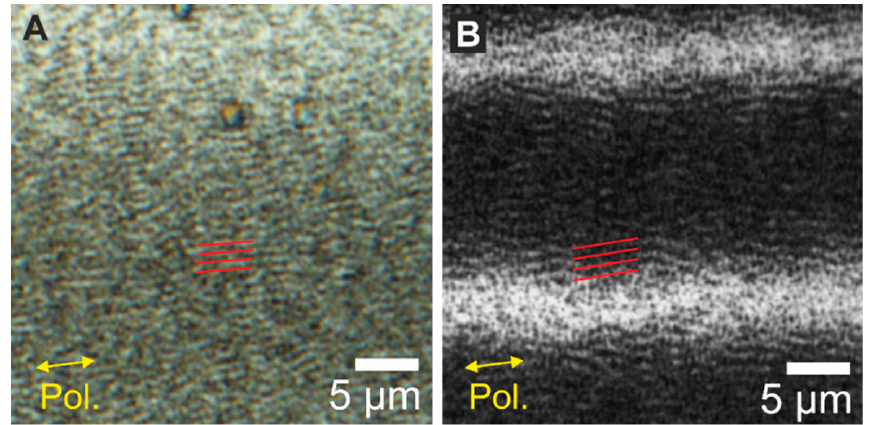
Figure 4. Morphological characterization via top-view optical microscopy (OM) of the samples irradiated with ( A ) Ti:Sa laser system ( λ = 790 nm), using the same parameters of Figure 3B, featuring the structures parallel to the laser polarization, highlighted with a set of four parallel red lines, and ( B ) Yb-doped fiber laser system ( λ = 1030 nm, φ 0 = 0.15 J / cm 2 , N e ff _1D = 1000), featuring LSFL structures parallel to the laser polarization highlighted with a set of four parallel red lines. In both cases, the yellow double arrows indicate the polarization